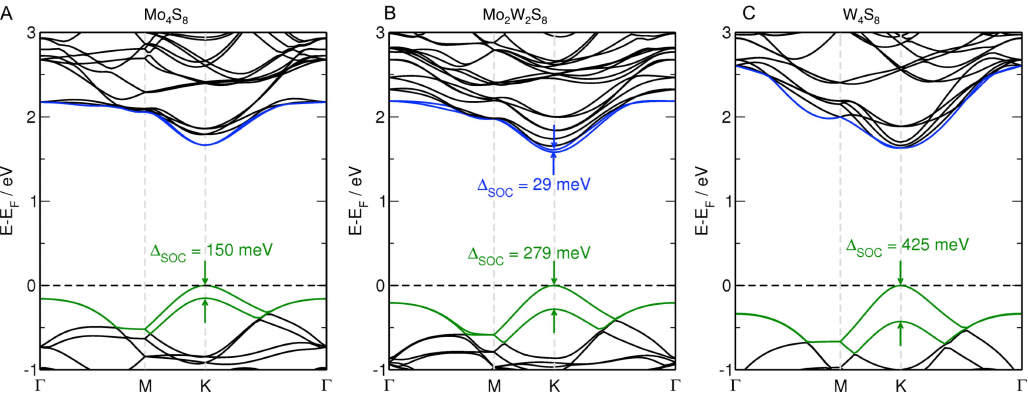
Figure 5. Calculated band structures of MoS 2 , WS 2 and Mo 0.5 W 0.5 S 2 systems with spin-orbit coupling ( ∆ SOC